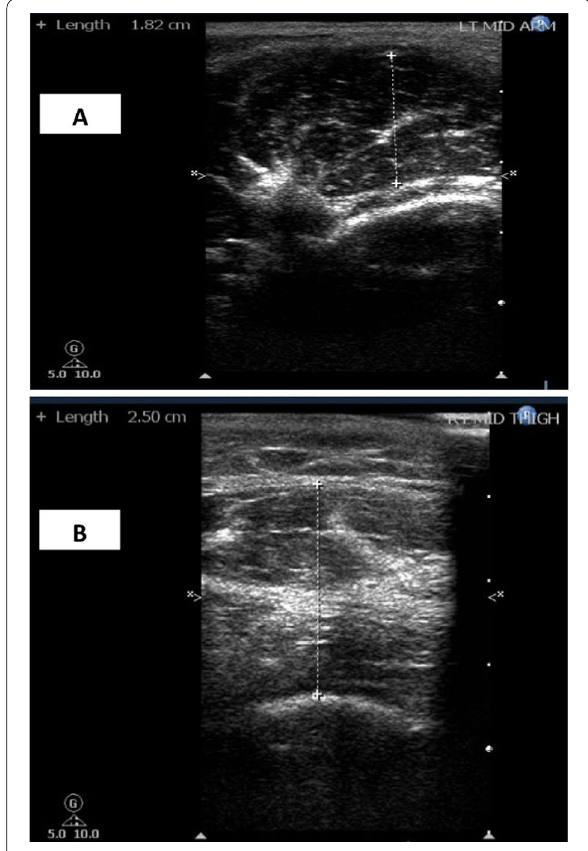
Fig. 6 A , B A male liver cirrhosis patient, 63 years old, HCV positive, BMI: 17.4, NRS 4. His labs: albumin: 2/total bilirubin: 4/INR: 3/ creatinine: 2.4/Child C score 15. HGS: 14.2. A USG mid upper arm of Child C patient, which positively correlated with HGS. B USG mid‑thigh of Child C patient, which positively correlated with